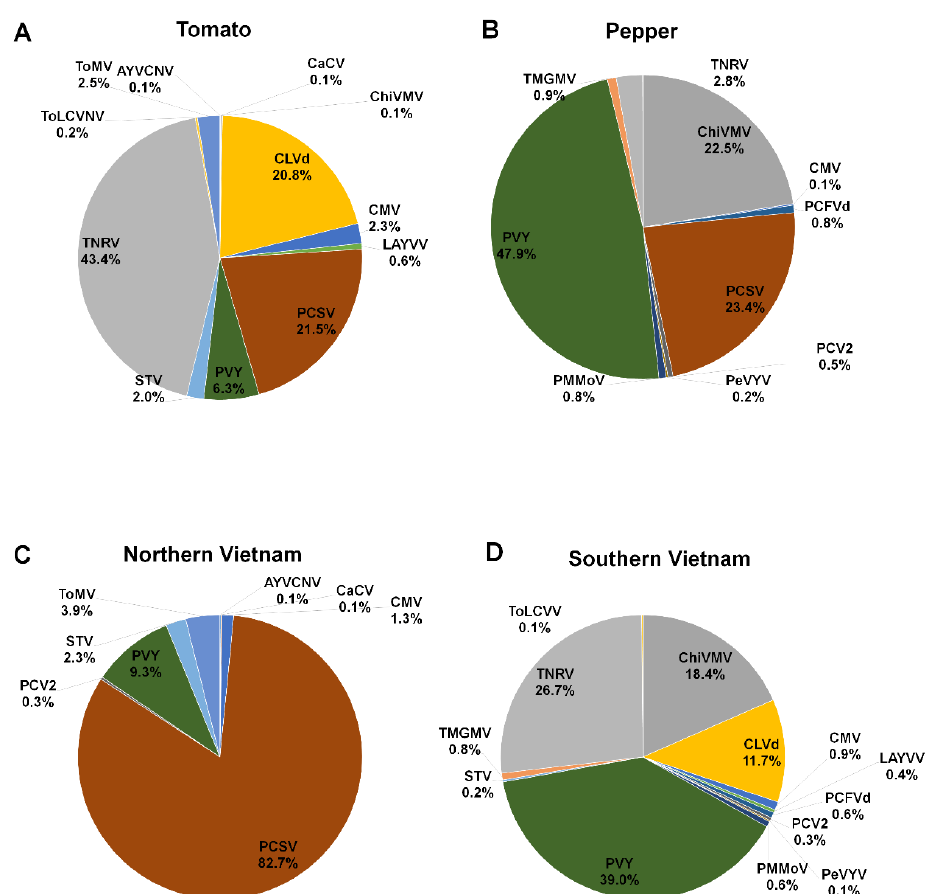
Figure 5. The proportion of identified viral pathogens according to host plants and geographical regions. Pie charts display proportion of identified viral pathogens in tomato ( A ) and pepper ( B ) plants according to virus-associated reads. The proportion of identified viral pathogens in northern ( C ) and southern Vietnam ( D ) based on virus-associated reads.